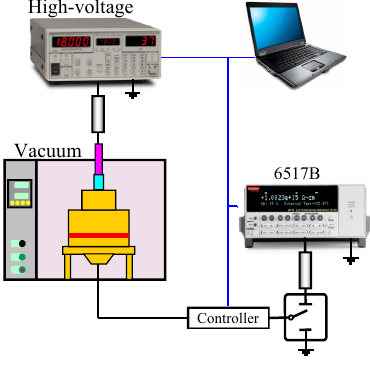
Figure 1. Test schematic.